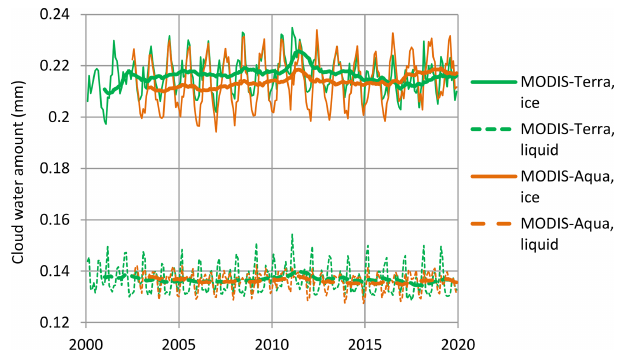
Figure 9. Variation of cloud water amount (in ice and the liquid phase). Thin and thick lines of the same colour represent monthly values and running annual averages (right aligned), respectively. Sources of the data are indicated in the legend and detailed in Ta- ble